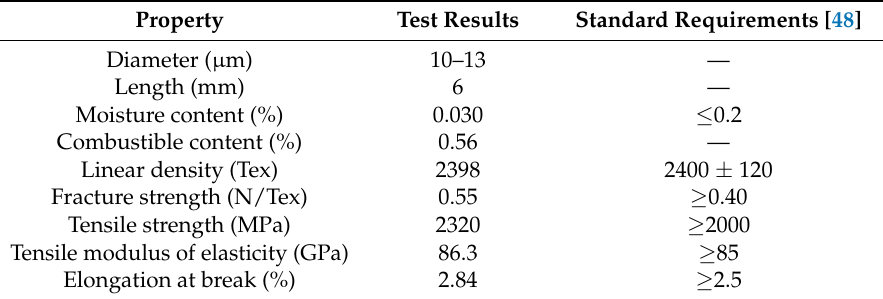
Table 2. Technical properties of basalt fiber.